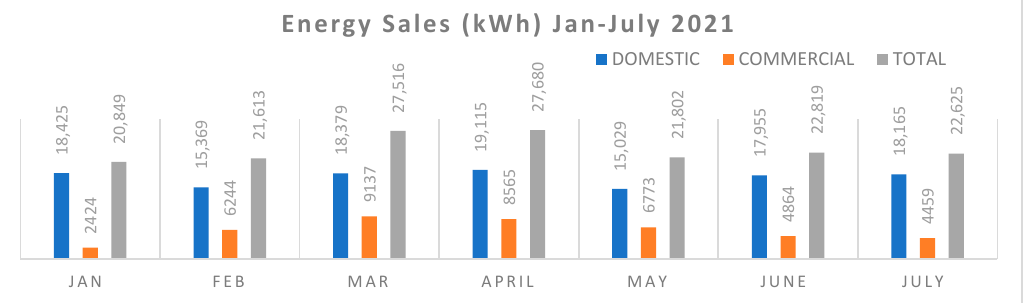
Figure 5. Energy Sales January–July 2021.